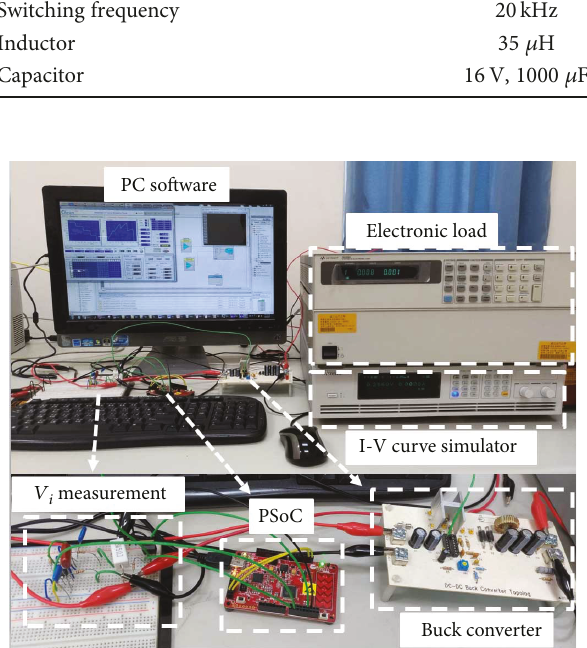
Figure 10: Photograph of the evaluation